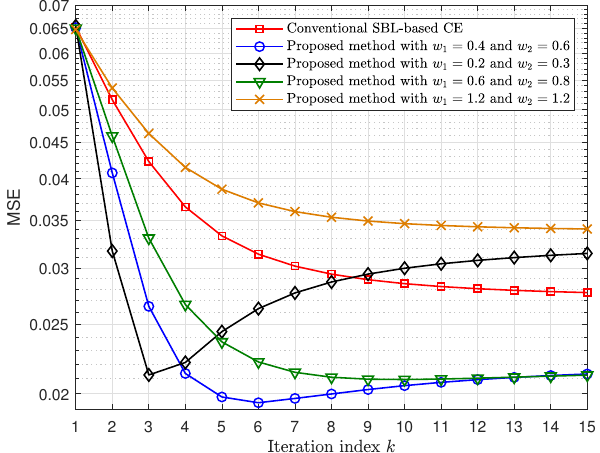
Figure 3. The convergence of the proposed method compared with the conventional SBL CE for SNR = 10 dB.